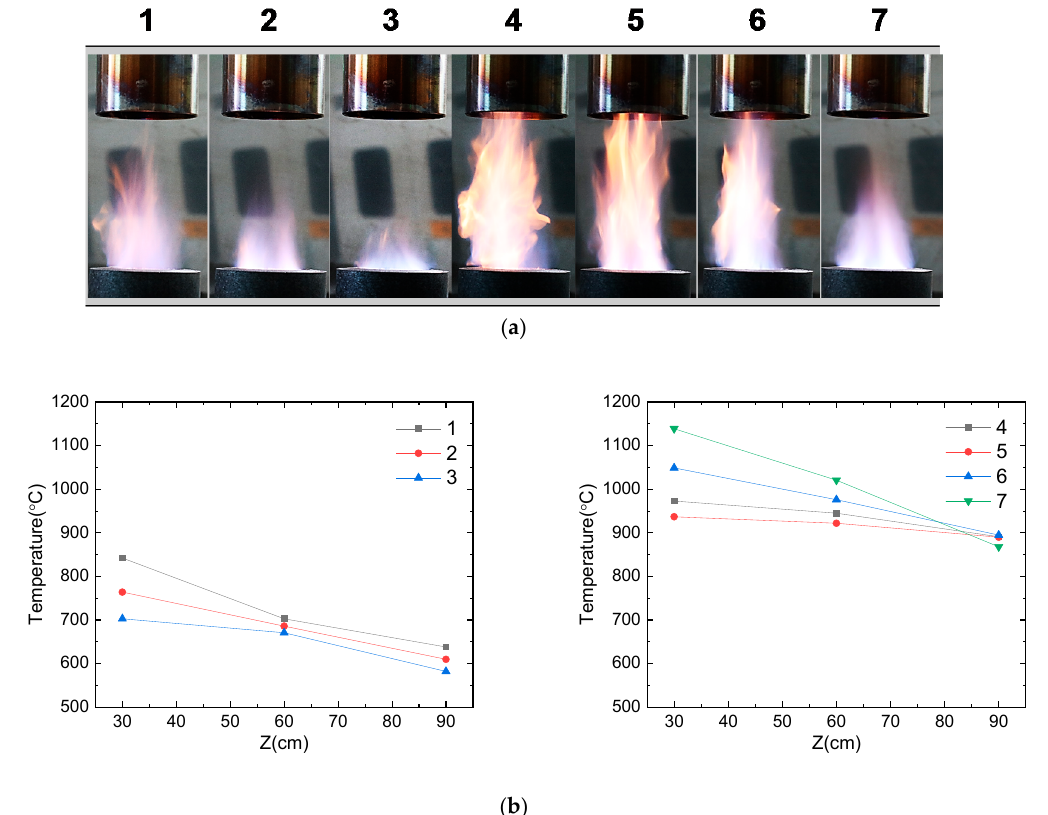
Figure 2. Flame characteristics with different ratios of fuel/oxidant gases (CH 4 /O 2 ): ( a ) real-time images of flames and ( b ) temperature profile of each flame (#1 – 7) as a function of lengths (cm) from the flame burner.